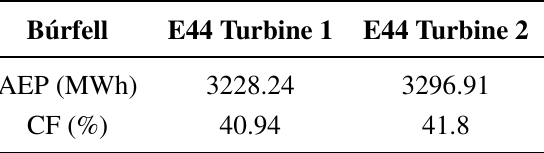
Table 8. Scaled measured AEP and CF for both 900-kW wind turbines at